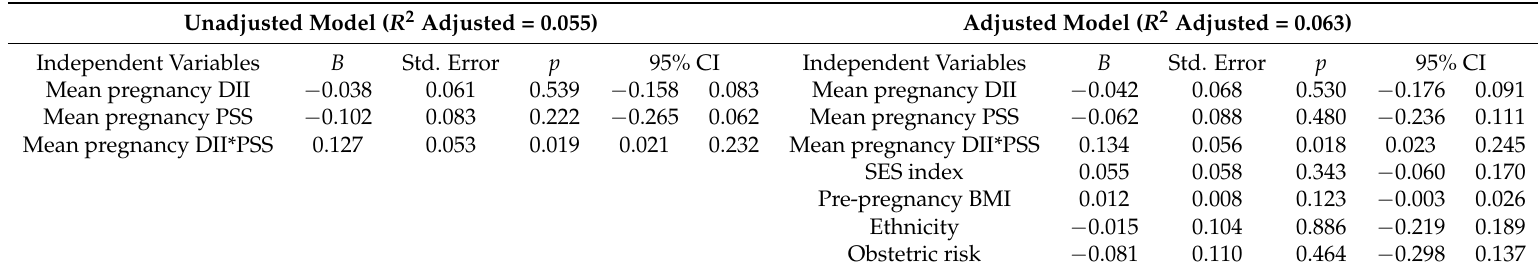
Table 4. Interactive effect of DII*PSS on TNF- α across pregnancy, unadjusted and adjusted for maternal